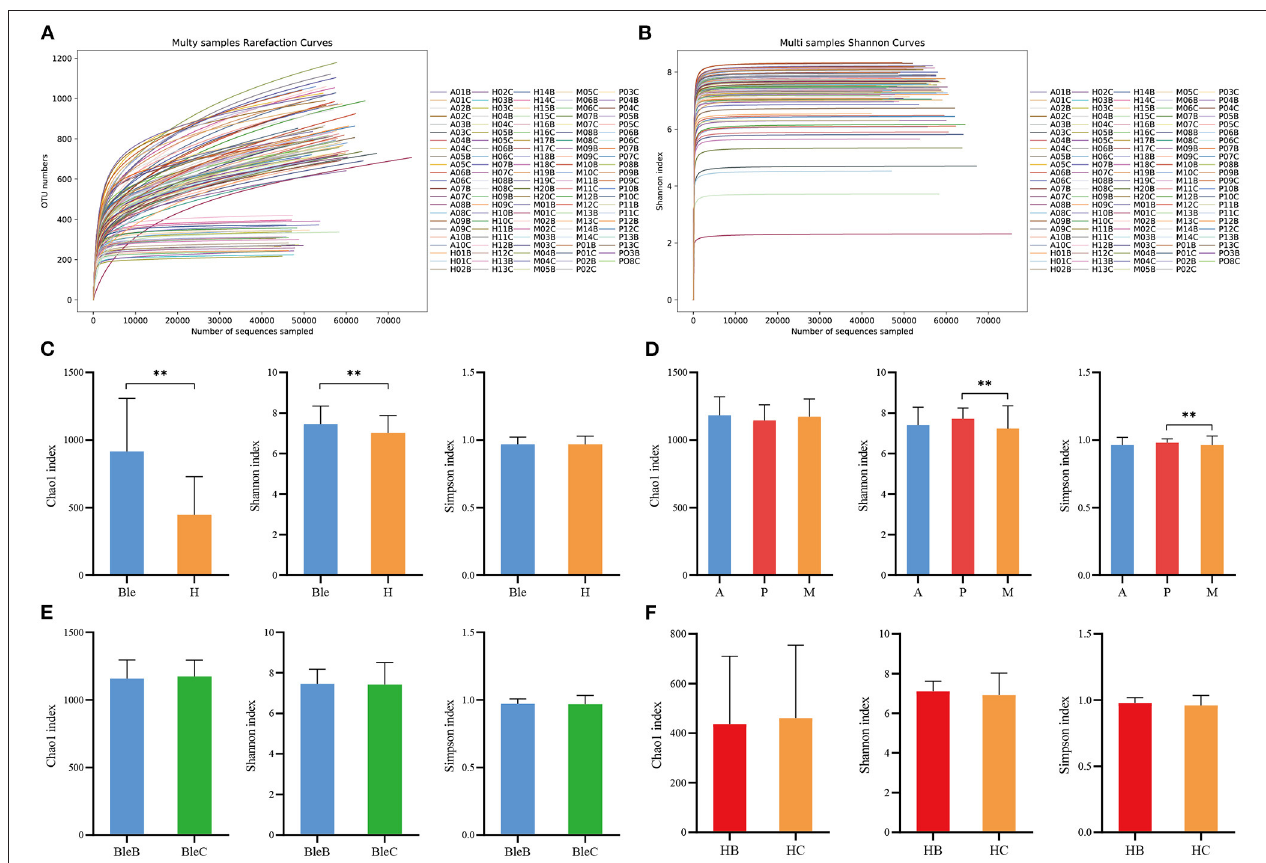
FIGURE 1 | The α -diversity analysis of the samples. (A) Multisample rarefaction curves and (B) Shannon index curves. All rarefaction curves and Shannon index curves of the samples reached the saturation of the platform, indicating that the sequencing data size was adequate. (C) Comparisons of α -diversity indices between the blepharitis group (Ble) and healthy control group (H). (D) Comparisons of α -diversity indices among the anterior blepharitis group (A), posterior blepharitis group (P), and mixed blepharitis group (M). (E) Comparisons of α -diversity indices between the eyelid margin samples (BleB) and the conjunctival sac samples of the blepharitis group (BleC). (F) Comparisons of α -diversity indices between the eyelid margin samples (HB) and the conjunctival sac samples of the healthy control group (HC). ** P <